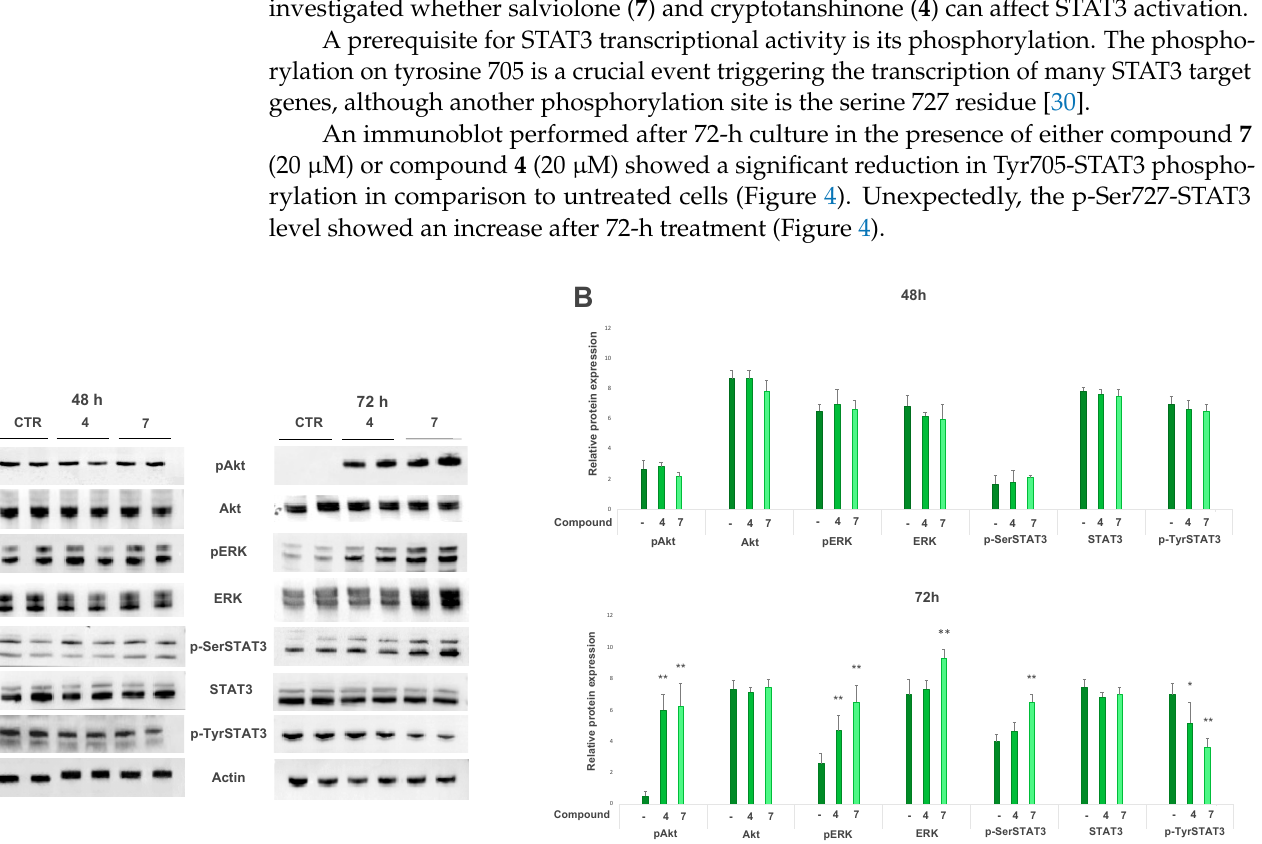
Figure 4. Cryptotanshinone ( 4 ) and salviolone ( 7 ) effect on protein expression involved in pro-survival signaling. A375 melanoma cells were cultured in the presence (20 µM) or absence of cryptotanshinone ( 4 ) or salviolone ( 7 ) for 48 and 72 h. Immunoblots show the expression levels of ( A ) the activated and total forms of the signal transducer and activator of transcription (STAT)3, the extracellular signal-regulated kinases (ERK)1/2 and the protein kinase B (Akt); ( B ) histograms show mean values ± SD of the protein expression level measured after 48 or 72 h deriving from three to four independent experiments. All comparisons were performed vs. each control sample after normalization with β -actin expression. * p < 0.05; ** p < 0.01.